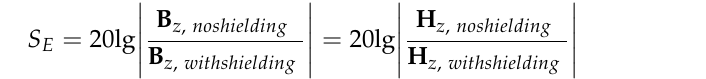
Table 11. Limits of typical standards regarding electric field strength, magnetic field strength, and magnetic flux density in the dominant operating range of WPT systems. Standards Frequency Range